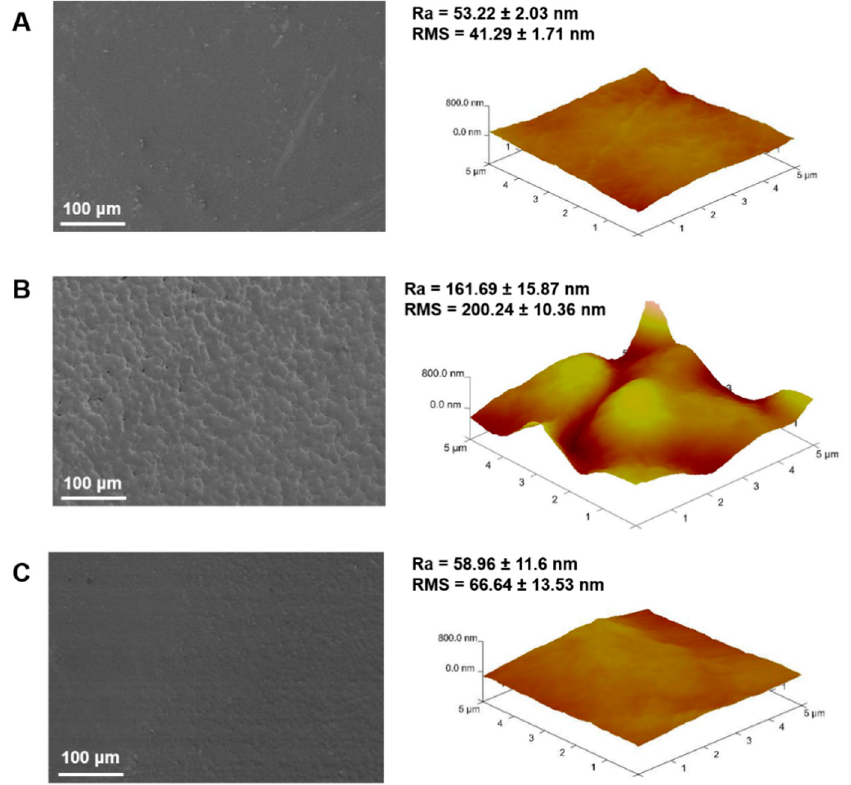
Figure 2. SEM micrographs (left) and AFM 3D perspective images with their respective calculated roughness parameters (right) for Ch ( A ), Ch/HA ( B ), and Ch/HAMA ( C ) polymeric membranes.